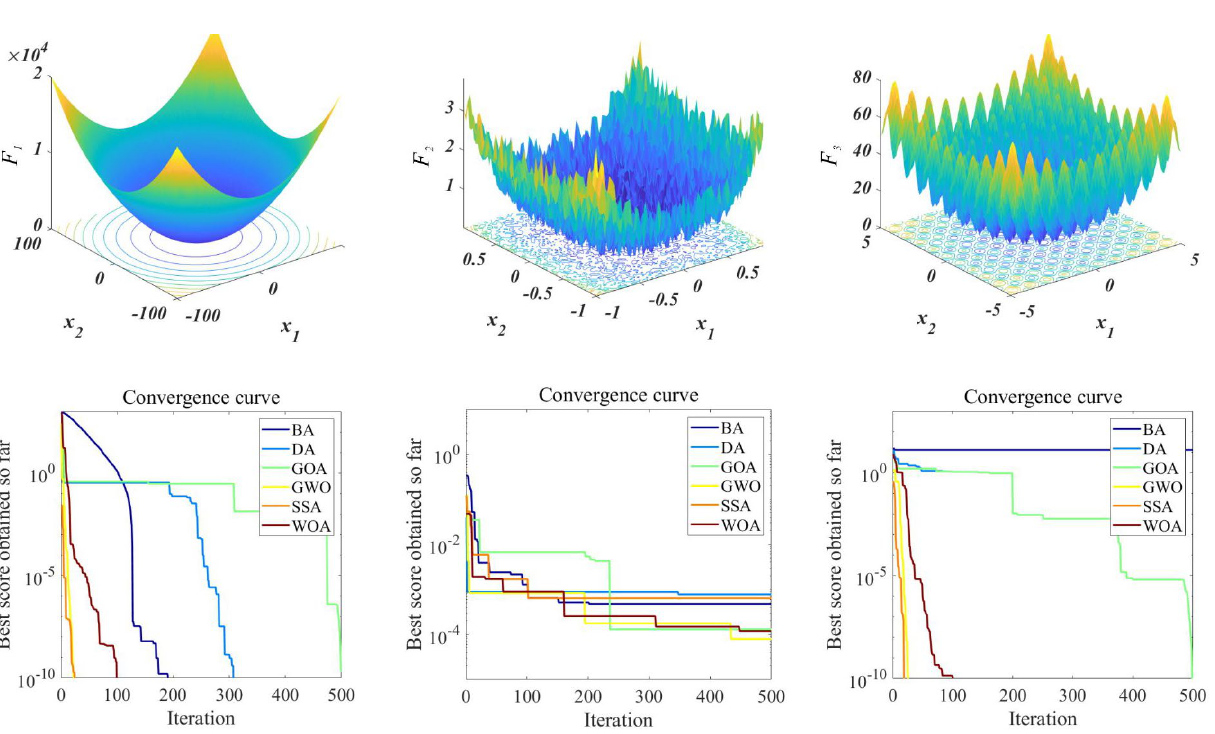
Figure 14. Iterative curves of three benchmark functions solved using multiple-SI.